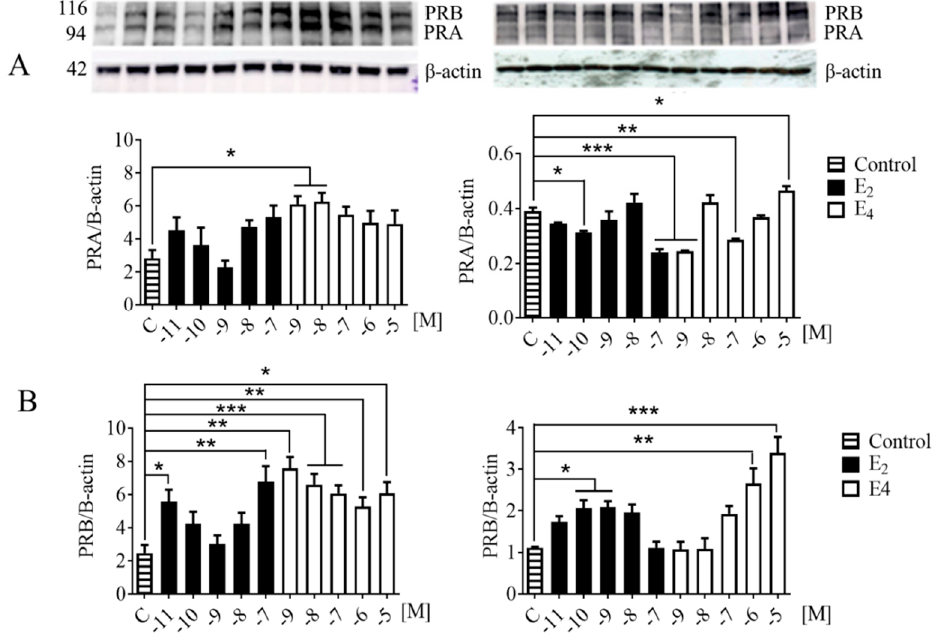
Figure 3. PRs protein levels measurement by Western blot after E2 or E4 treatments in endometriotic cells. ( A ) PRA levels over β -actin levels (AU) for 11Z cells (left) and Hs832 (right). ( B ) PRB levels over β -actin levels (AU) for 11Z cells (left) and Hs832 (right) ( n = 3), * p < 0.05, ** p < 0.01, *** p < 0.001, by one-way ANOVA along with Dunnett’s post hoc test.